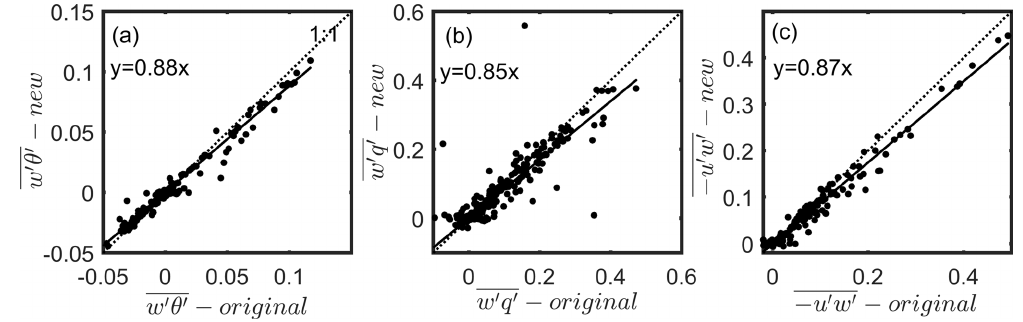
Figure 5. A comparison of the vertical heat flux ( w (cid:48) θ (cid:48) ) (a) , vertical water-vapour flux ( w (cid:48) q (cid:48) ) (b) , and momentum flux ( − u (cid:48) w (cid:48) ) (c) from the new half-hourly results with those from the original results from 16 December 2016 to 8 January 2017 at the suburban site. The black dotted line represents the 1 : 1 line in the figure. The black solid line represents the fitted